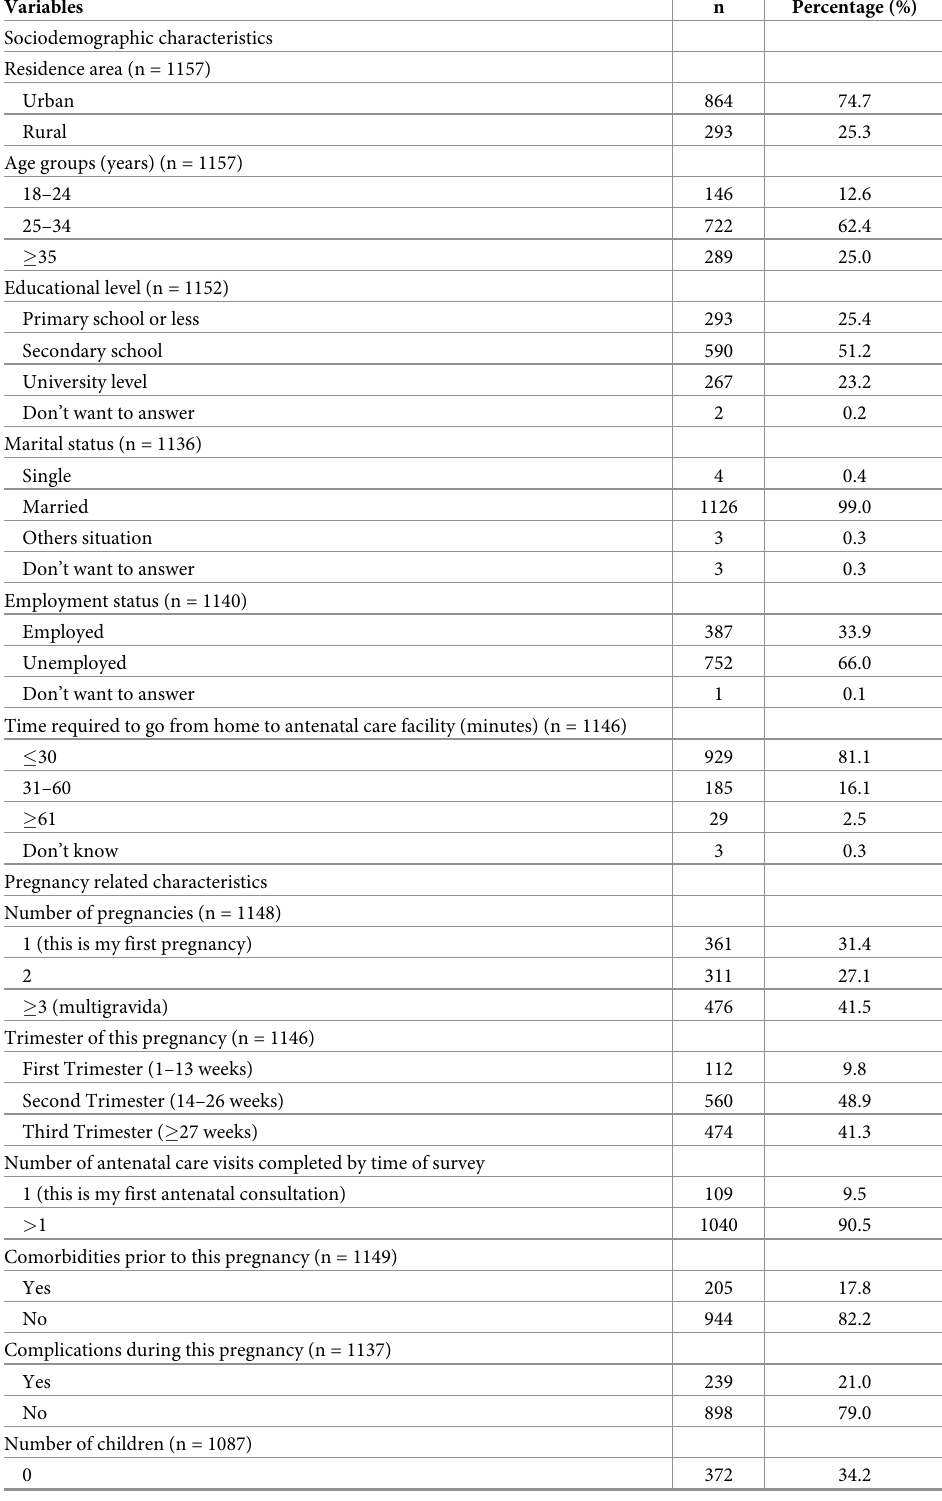
Table 1. Socio-demographic and pregnancy characteristics of the enrolled women, (n =